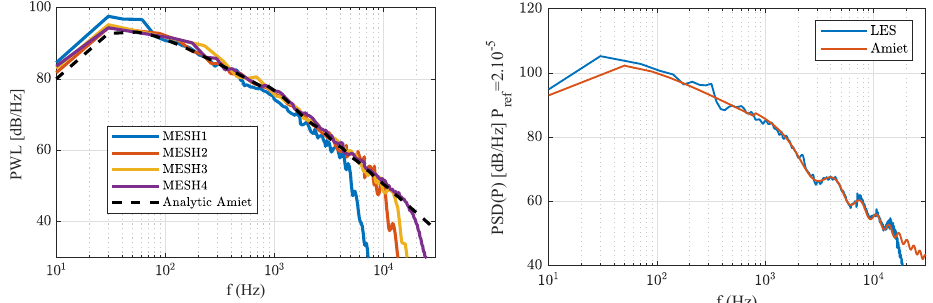
Figure 10. Comparison of the power spectral level PWL for the different meshes at a distance of 8 c ( left ) and the pressure PSD 90 ◦ from the plate’s leading edge at a distance of 8 c for MESH4 ( right ) with the analytical solution of Amiet’s